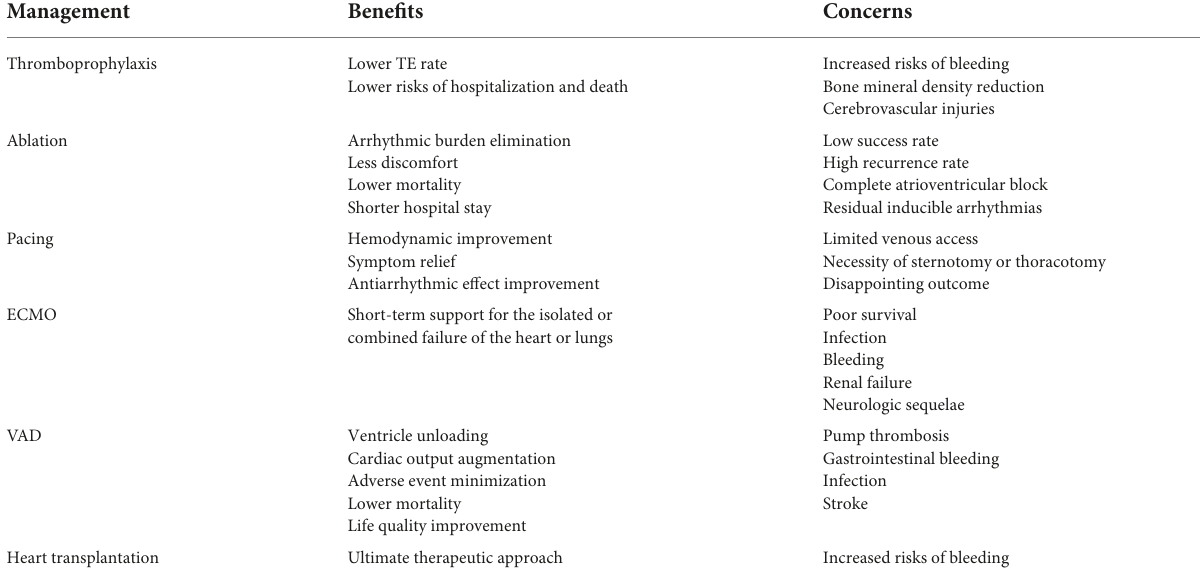
TABLE 3 Benefits and concerns of the management associated with Fontan